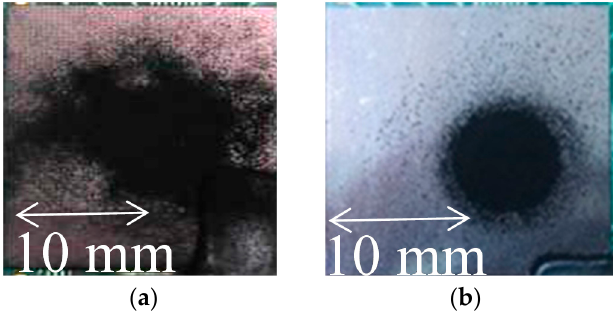
Figure 10. Particle deposition before and after optimization: ( a ) without mask at a flow rate of 12.5 L/min and ( b ) using mask with 6 ‐ mm aperture at a flow rate of 7.5 L/min.